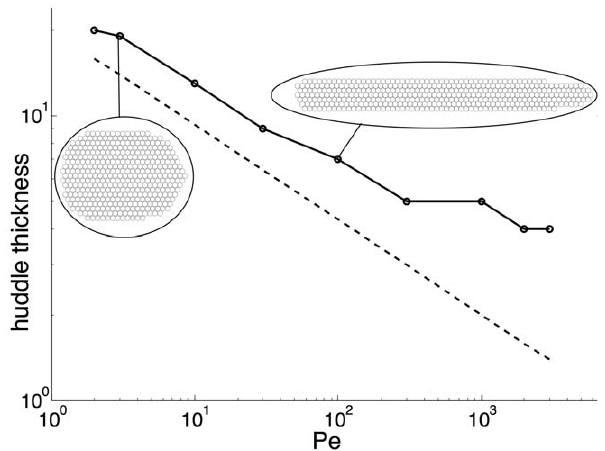
Figure 3. Dependence of the huddle shape on the Pe´clet number. Logarithm of the width, W , of model huddles consisting of N =400 penguins as a function of the logarithm of the Pe´clet number (solid line) in the deterministic model. For comparison, the dashed line has equation W ~ 20 Pe { 1 = 3